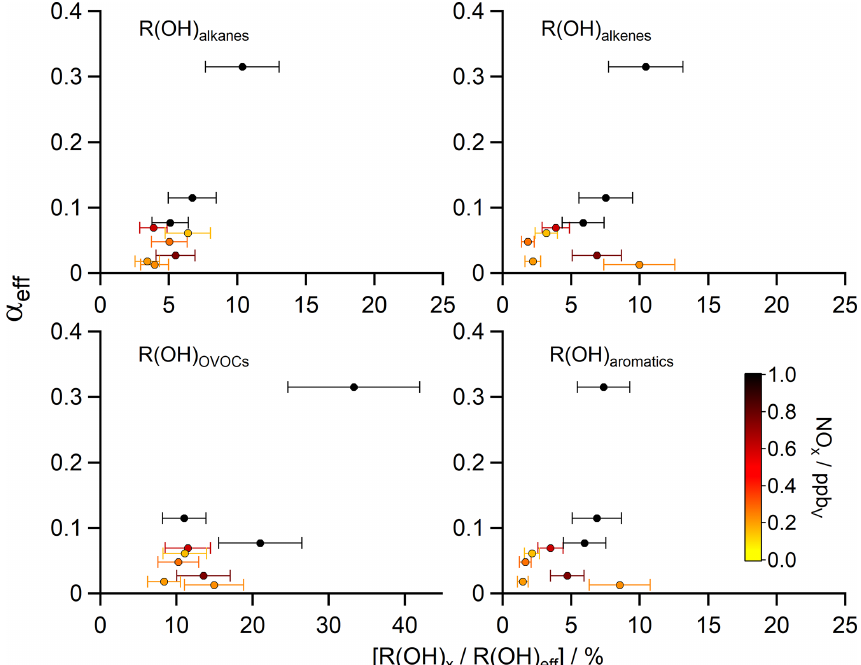
Figure 5. Scatter plots of the contribution of certain substance classes R ( OH ) x (e.g. alkanes, alkenes, OVOCs, aromatics) to the total OH reactivity without the contribution of inorganic reactions ([R ( OH ) x / R ( OH ) eff ]) versus the HCHO yield α eff (calculated with R ( OH ) eff via Eq. 6). The z axis was color-coded with the measured NO x median values, representative for the nine different regions during AQABA (Table